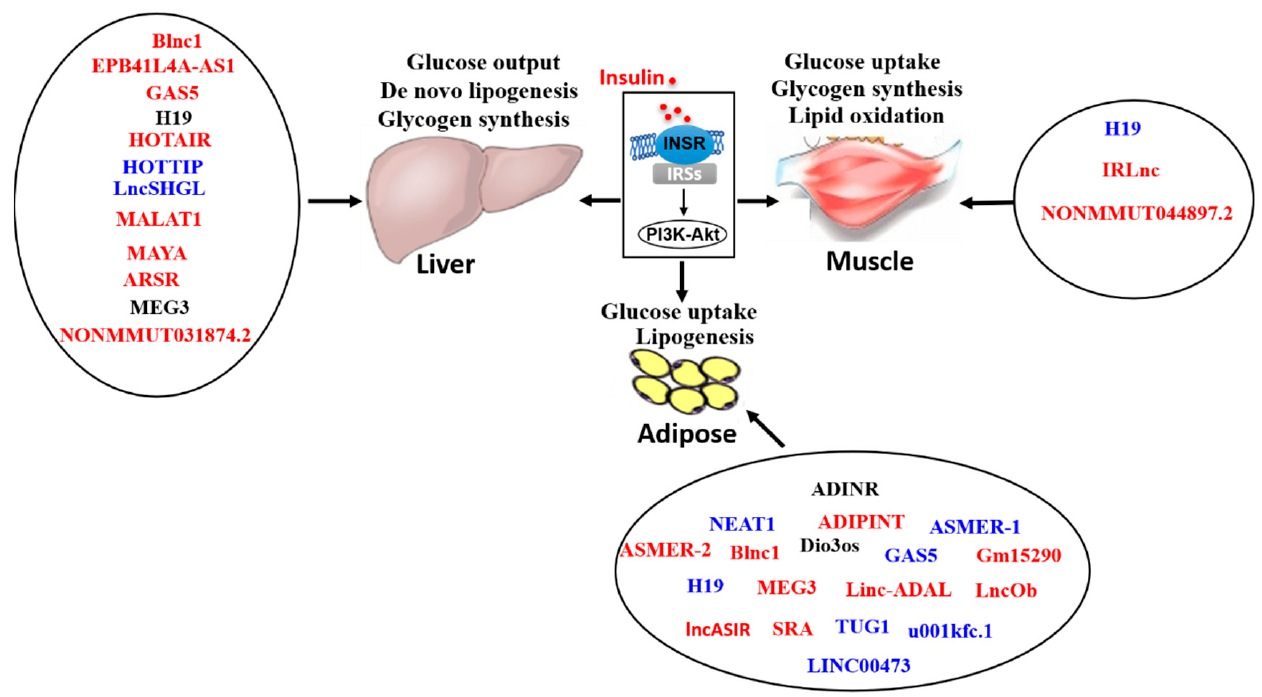
Figure 1. A deregulated lncRNA profile is involved in the pathogenesis of insulin resistance and dysregulated glycolipid metabolism in various tissues. Under the condition of metabolic disorders, the declined expression of lncRNAs are marked in blue, and the increased expression of lncRNAs are marked in red, while those with unknown or controversial expression are marked in black in liver, skeletal and adipose tissues. Generally, upregulated lncRNAs are negative regulators of the insulin signaling pathway, while downregulated lncRNAs exert beneficial effects on insulin sensitivity and glycolipid metabolism. INSR, insulin receptor; IRSs, insulin receptor substrates.